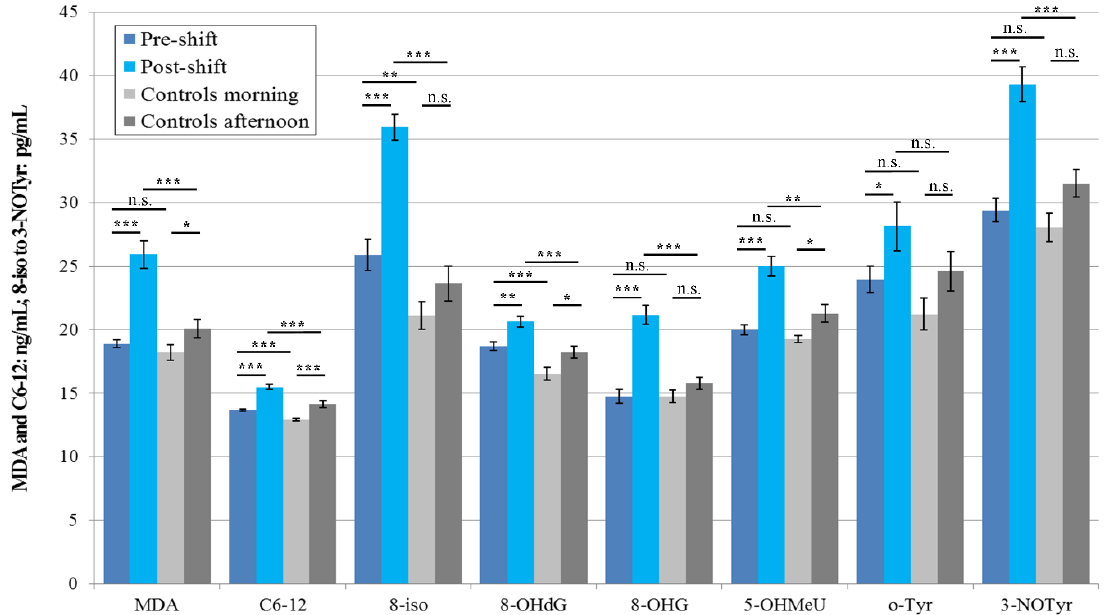
Figure 2. Mean and standard deviation of the levels of eight markers of oxidative stress in the EBC of the 21 workers (shift = welding or machining) and 18 control subjects in 2018, * p < 0.05, ** p < 0.01, *** p < 0.001, n.s. = not significantly di ff erent, EBC = exhaled breath condensate, MDA = malondialdehyde, C6-12 = aldehydes C6-12, 8-iso = 8- iso -prostaglandin F2 α (8-isoprostane), 8-OHdG = 8-hydroxy-2-deoxyguanosine, 8-OHG = 8-hydroxyguanosine, 5-OHMeU = 5-hydroxymethyl uracil, o-Tyr = o -tyrosine, 3-NOTyr = 3-nitrotyrosine.